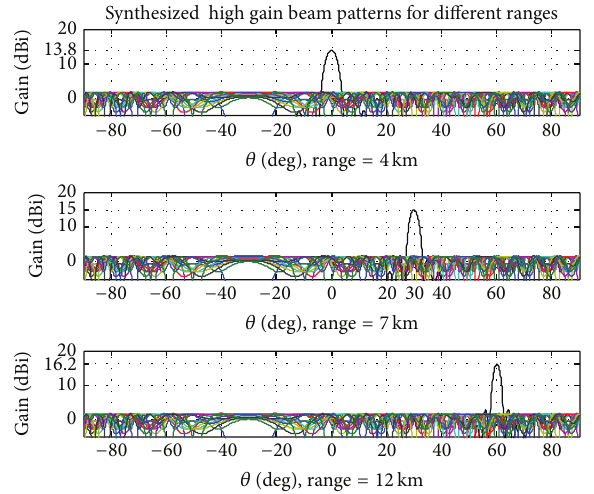
Figure 10: Synthesized respective beam patterns with gain in dBi.